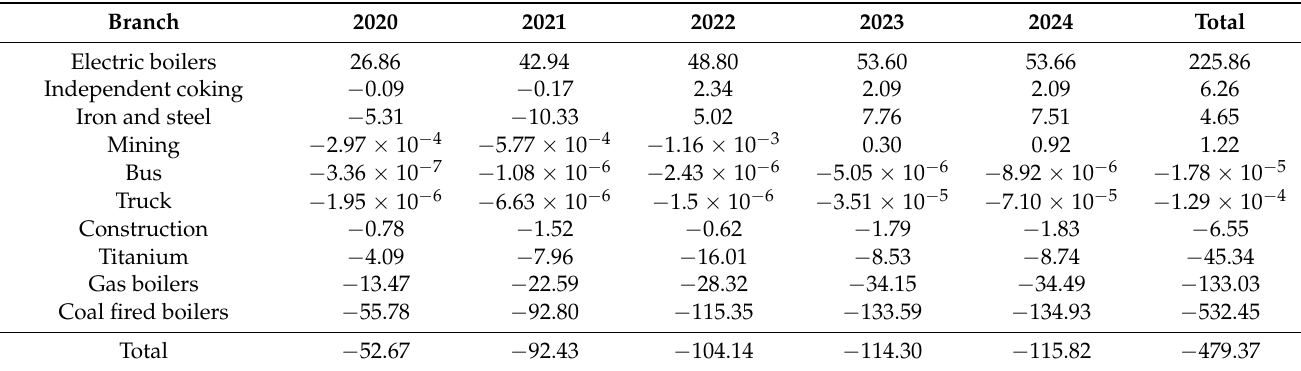
Table 12. Table of total carbon emissions for each module versus the baseline